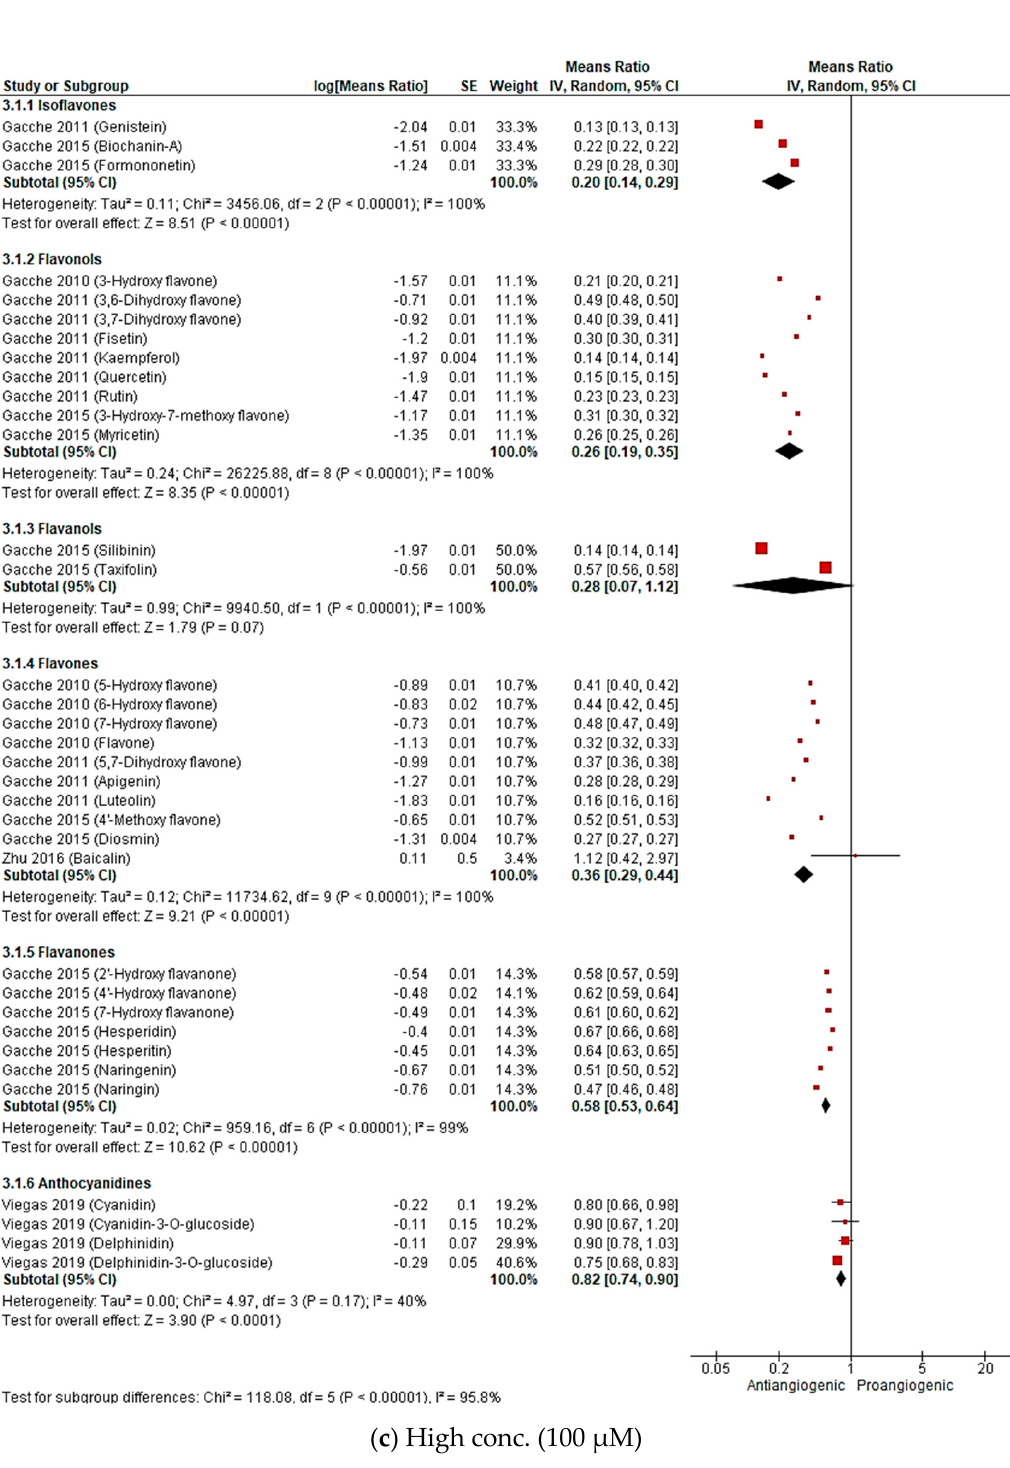
Figure 6. Forest plots of means ratio and 95% confidence interval (CI) of number of blood vessels relative to control at 3 concentration ranges as calculated by inverse variance (IV) method: ( a ) low (10–20 µM); ( b ) medium (40–50 µM); ( c ) high (100 µM).